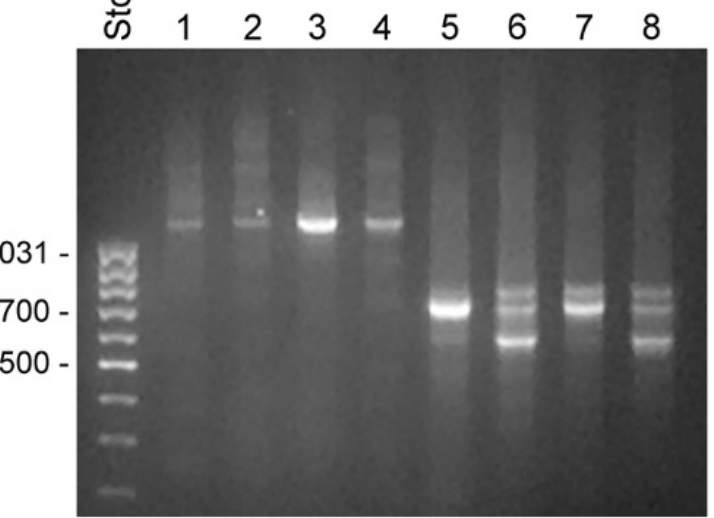
Figure 3. Transcripts detected by 5′ RACE in unfractionated BPH and compartments of LNCaP cells. RACE products were analyzed by electrophoresis in 1% agarose. Lanes 1–4 show 5′ RACE experiments using the KLK4T2-specific primer KLKP9R and lanes 5–8 using the primer KLK4r18, specific for classical and truncated KLK4. Products generated with unfractionated RNA from BPH are shown in lanes 1 and 5 and from LNCaP in lanes 2 and 6. Products generated with RNA from the cytosol of LNCaP are shown in lanes 3 and 7, and from the nucleus in lanes 4 and 8. MassRuler Low Range (Std) was used as size marker and relevant sizes in bp are written to the left.